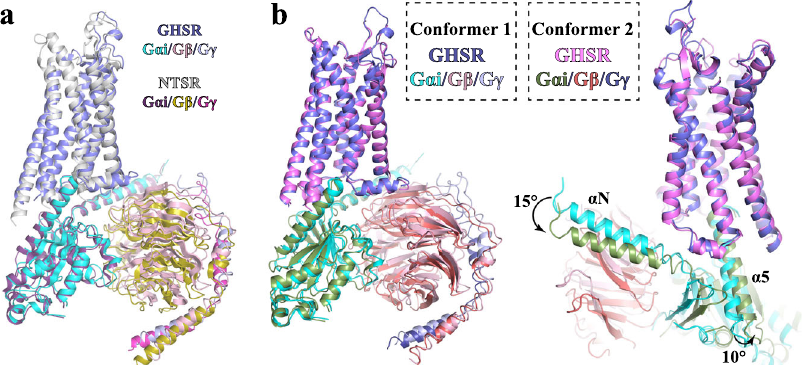
Fig. 6 Structures of the ghrelin-GHSR-G i complex in Conformer 1 and 2. a Structural alignment of the ghrelin-GHSR-G i complex in Conformer 1 with the neurotensin-NTSR-G i complex in the canonical state (PDB ID 6OS9). GHSR and NTSR are colored in slate and light gray, respectively. G α i , G β , and G γ subunits are colored in cyan, pink, and light blue, respectively, in the structure with GHSR, and in dark purple, olive, and warm pink, respectively, in the structure with NTSR. The G i -coupling mode is highly similar. b Structural alignment of the ghrelin-GHSR-G i complex in Conformer 1 and 2. G α i , G β , and G γ subunits are colored in cyan, pink and light blue, respectively, in Conformer 1, and in forest, ruby, and deep blue, respectively, in Conformer 2. GHSR is colored in slate in Conformer 1 and violet in Conformer